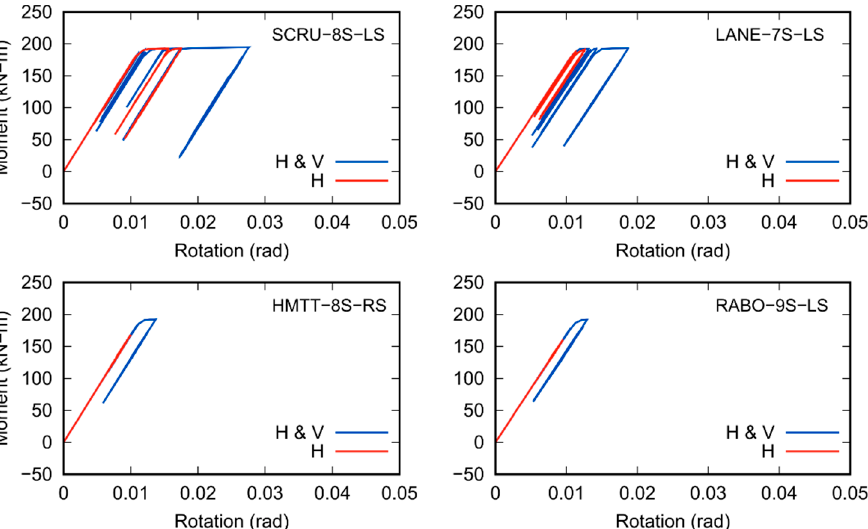
Figure 11. Non-linear response of the outer-most fiber in different beams for different earthquakes; 10-story buildings (Part 2).